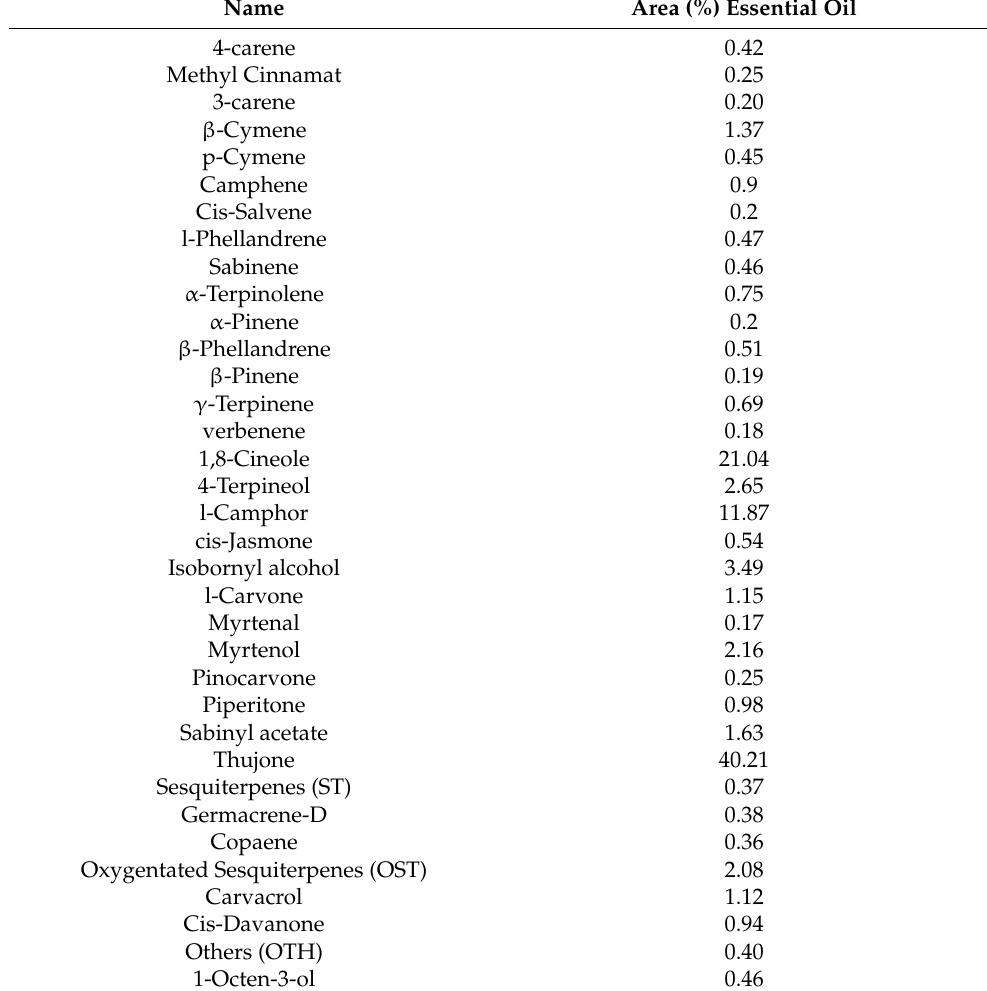
Table 1. Essential oil components of Artemisia fragrance used for chicken meat